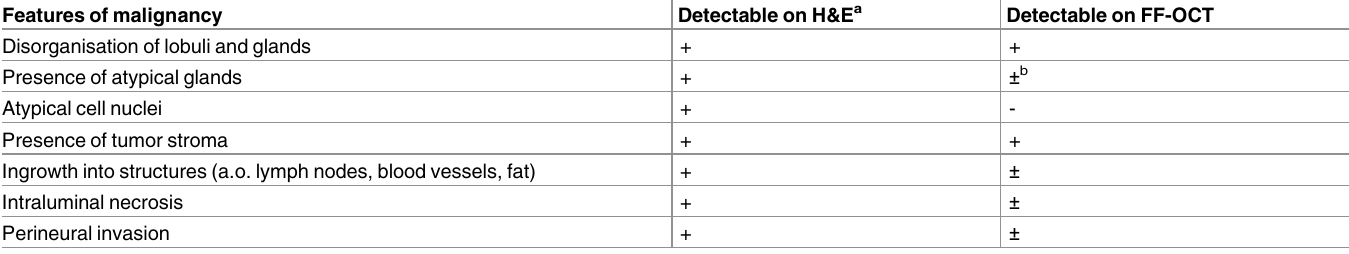
Table 1. Comparison of featuresof pancreatic ductal adenocarcinoma detectable on H&E and on FF-OCT images. Features of